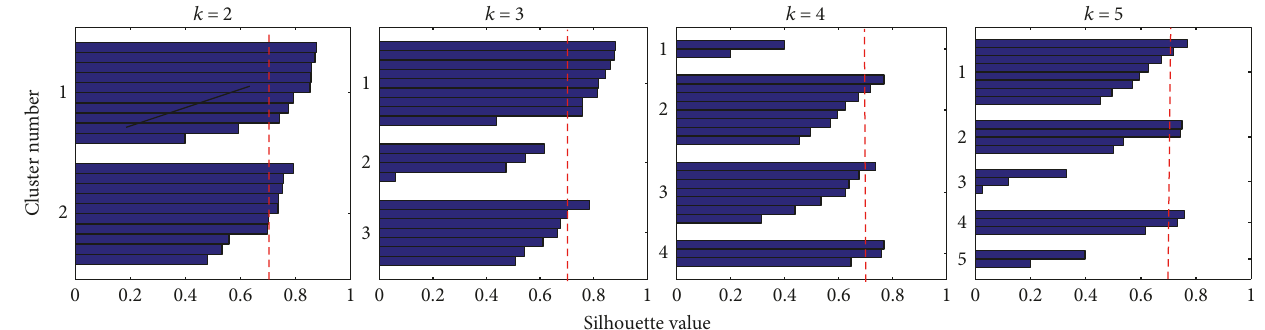
Figure 11: Cluster separation quality using k -means. Strongly separated clusters Sil > 0 71 are found at k = N or k = 2 . A common activation space control representation exists across subjects.